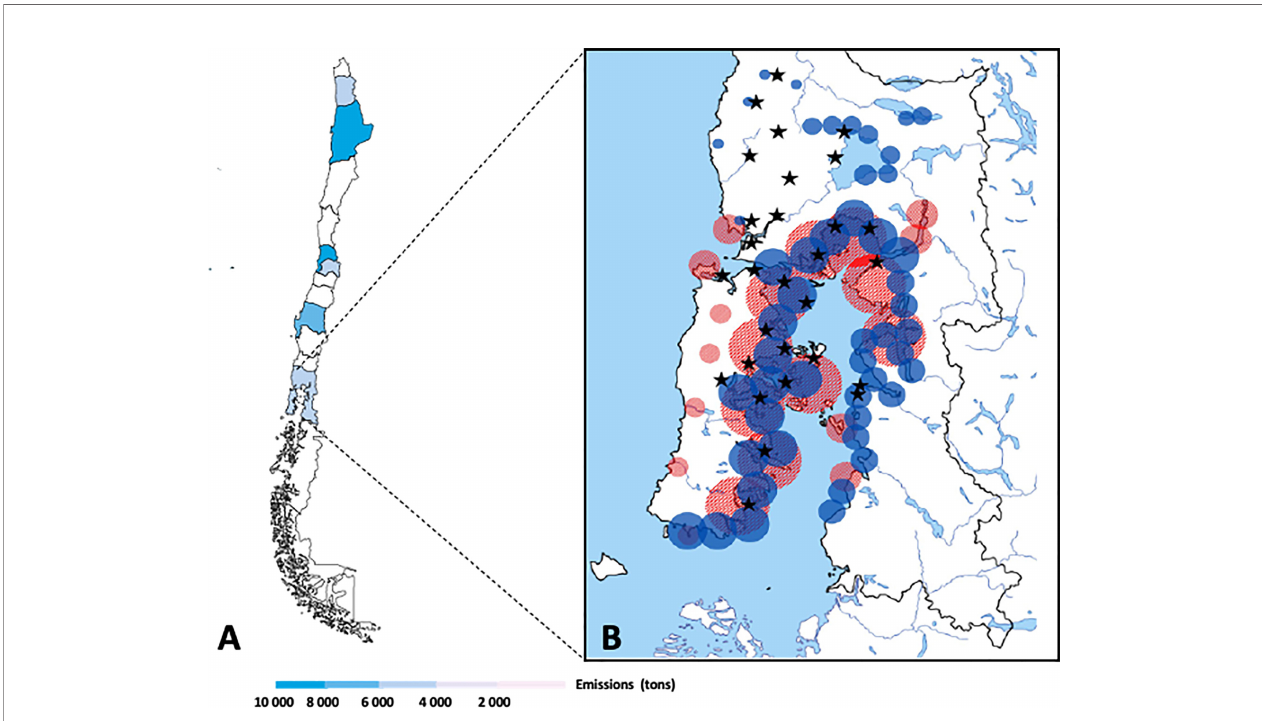
FIGURE 1 | Heavy metal pollution in Chile. (A) Heavy metals discharged in each Chilean region. Metal emissions in tons (t) can be observed in horizontal line below the map fi gure. (B) Colocalization of fi sh culture centers (red circles), mussels culture centers (blue circles) and wastewater plants (black stars) in Los Lagos